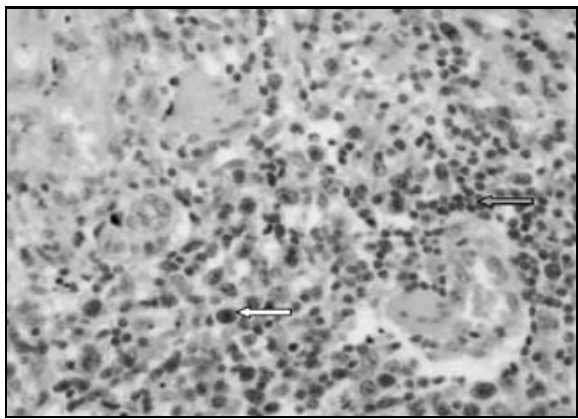
Figura 5 – Expressão da proteína p53 em núcleos de grandes células do componente de alto grau (seta clara) e ausência de expressão nas áreas de baixo grau (seta escura) (p53